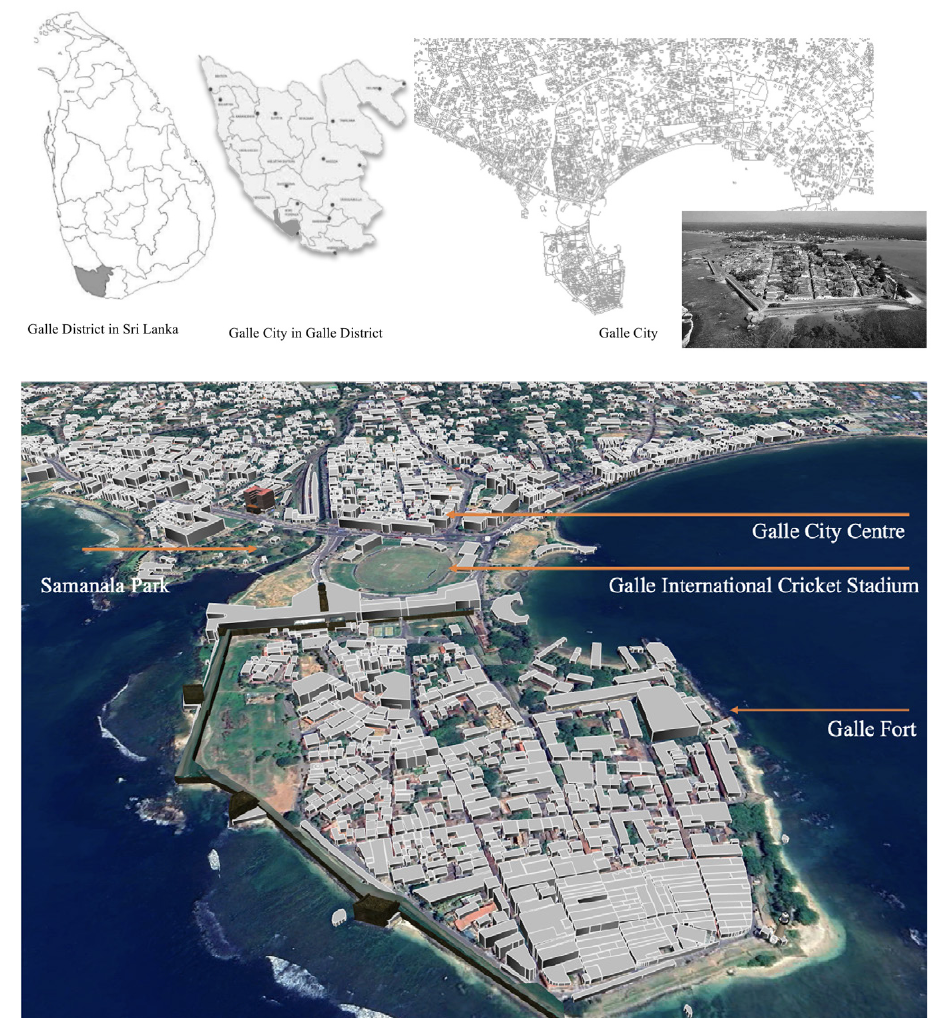
Figure 2. Location of the city of